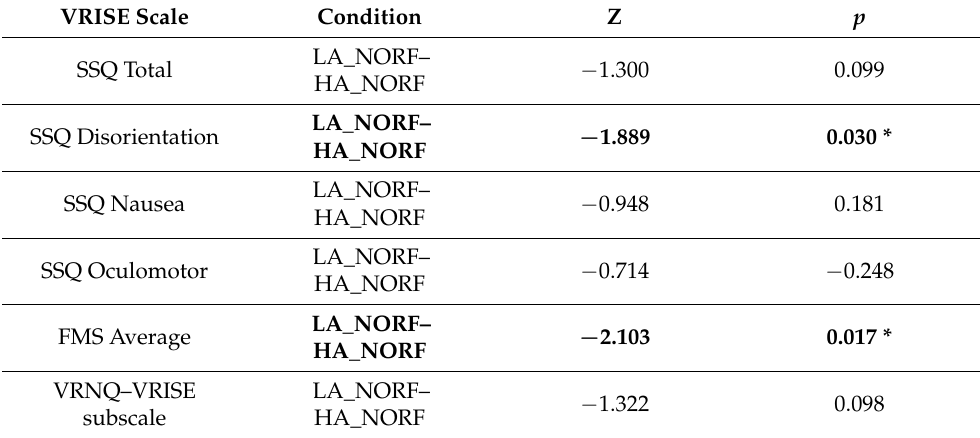
Table 4. Wilcoxon signed-rank test for the VRISE scores between mode of the game (LA vs. HA). VRISE Scale